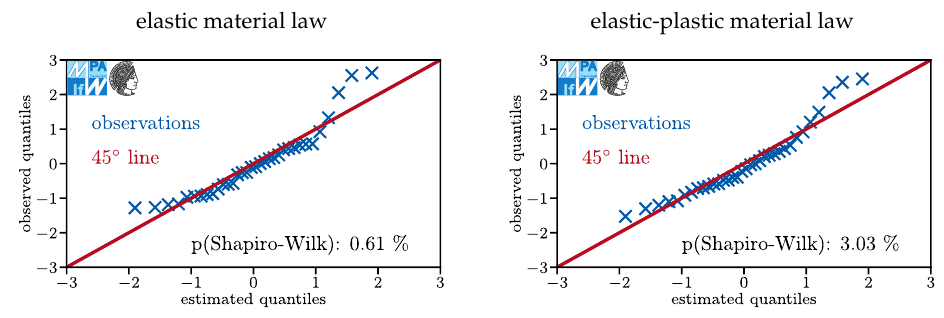
Figure A9. Quantile-quantile plots for 50CrMo4 specimens in argon; 919MPa ultimate tensile strength; K t = 1.75.